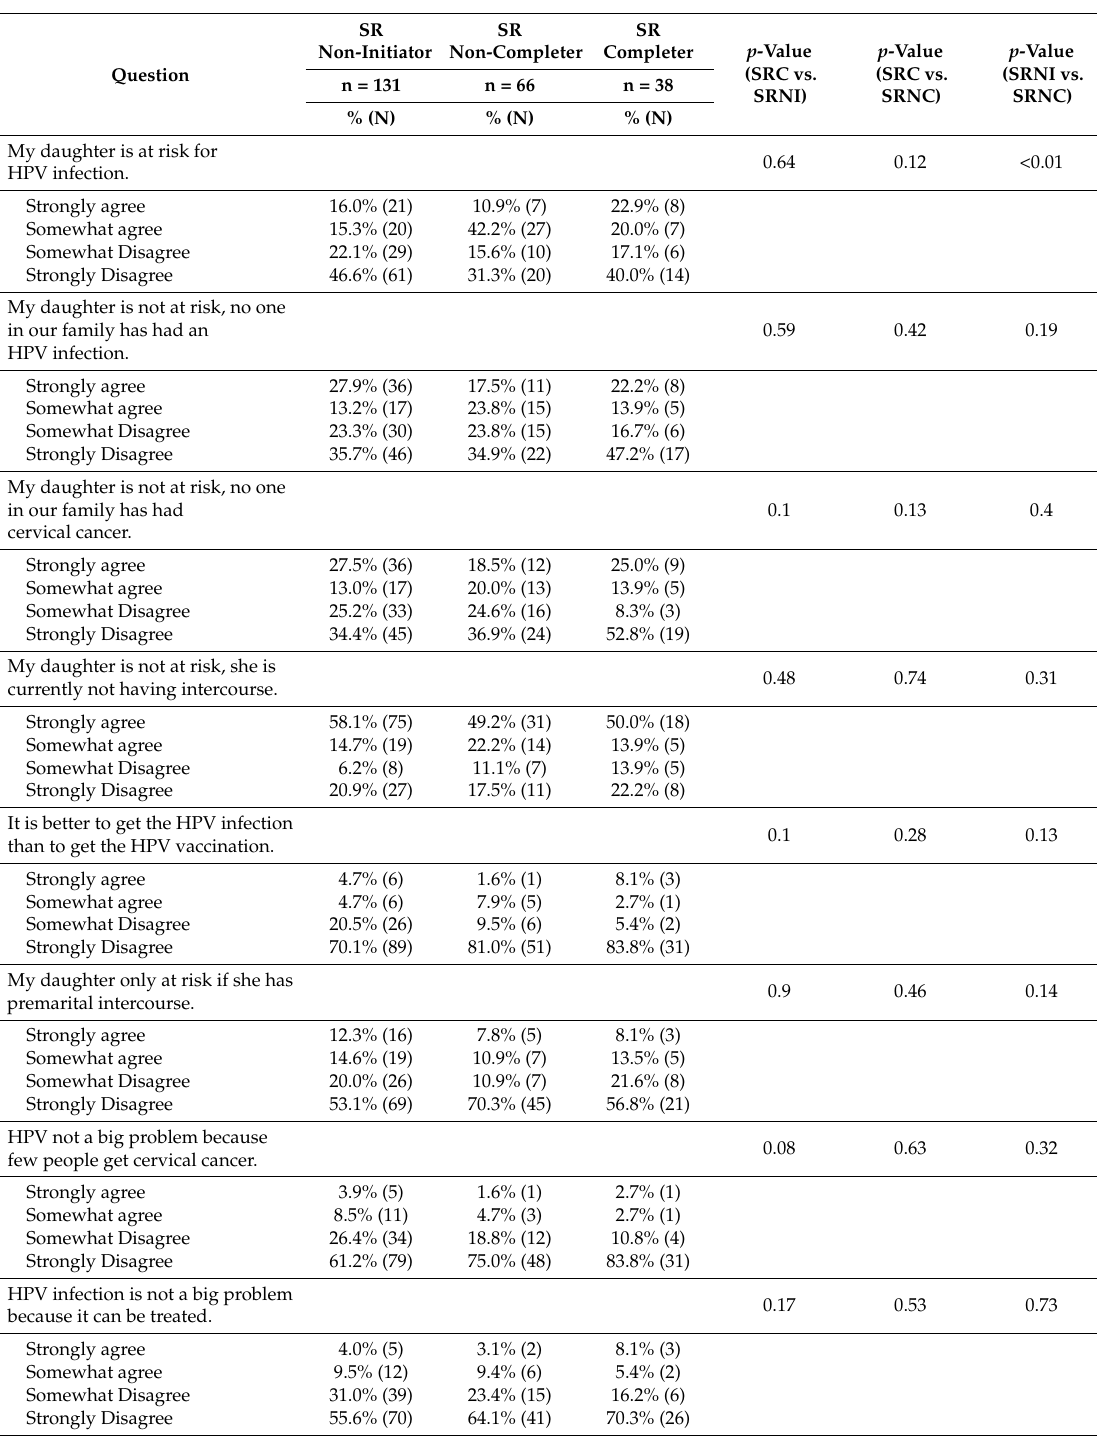
Table A2. Comparison of respondents based on self-report, including non-initiation, non-completion, and completion of the human papillomavirus vaccine